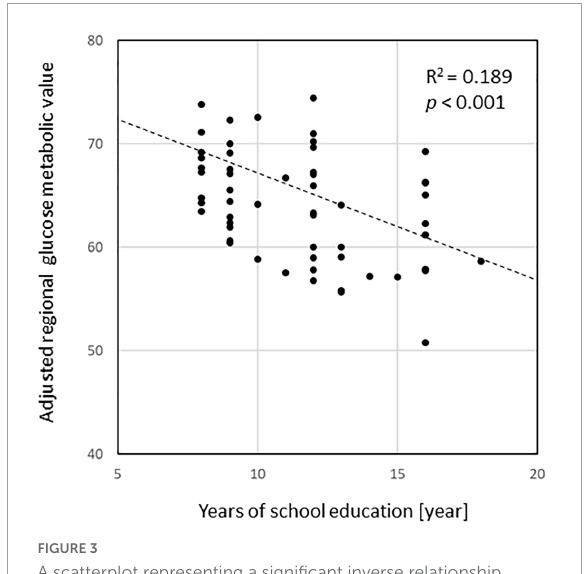
FIGURE3 A scatterplot representing a significant inverse relationship ( R 2 = 0.189, p < 0.001) between the years of education ( x -axis) and regional cerebral glucose metabolism in the left hippocampal cluster detected in the regression analysis ( y -axis). Glucose metabolism values were normalized with the mean value in individual images as